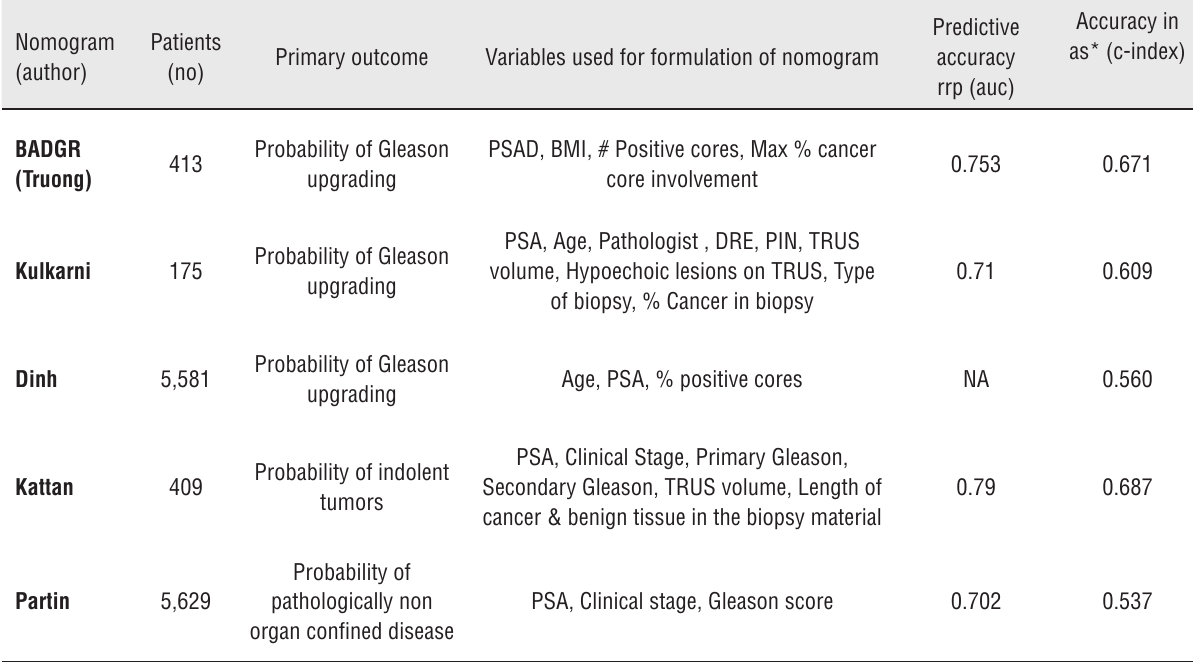
Table 3 - nomograms that predict pathologic (Gleason >6) upgrading at the time of radical prostatectomy and validation in as